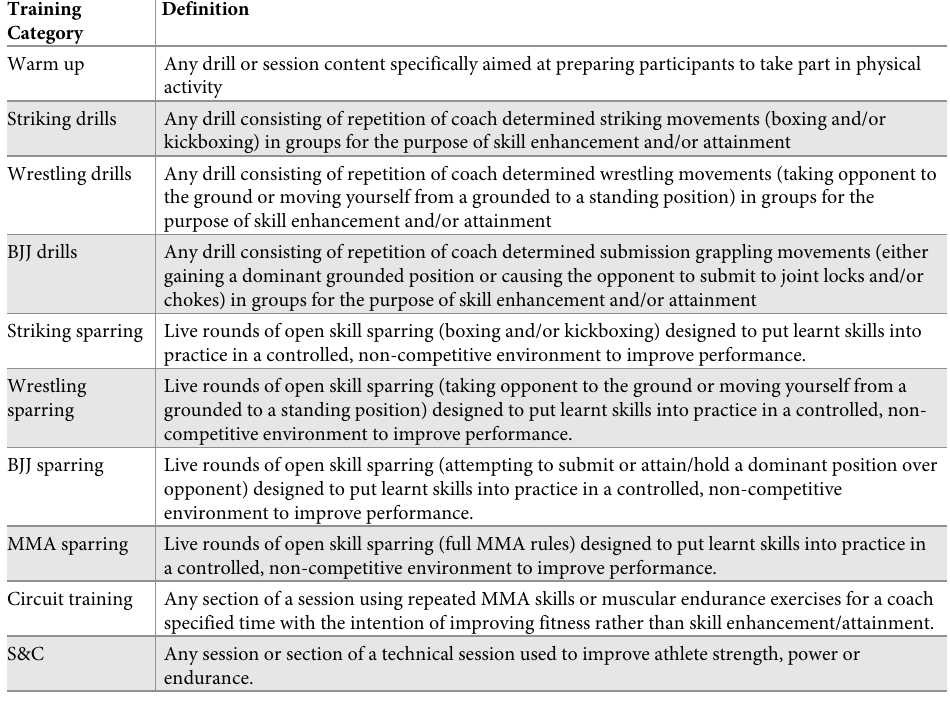
Table 2. MMA training category definitions used during data